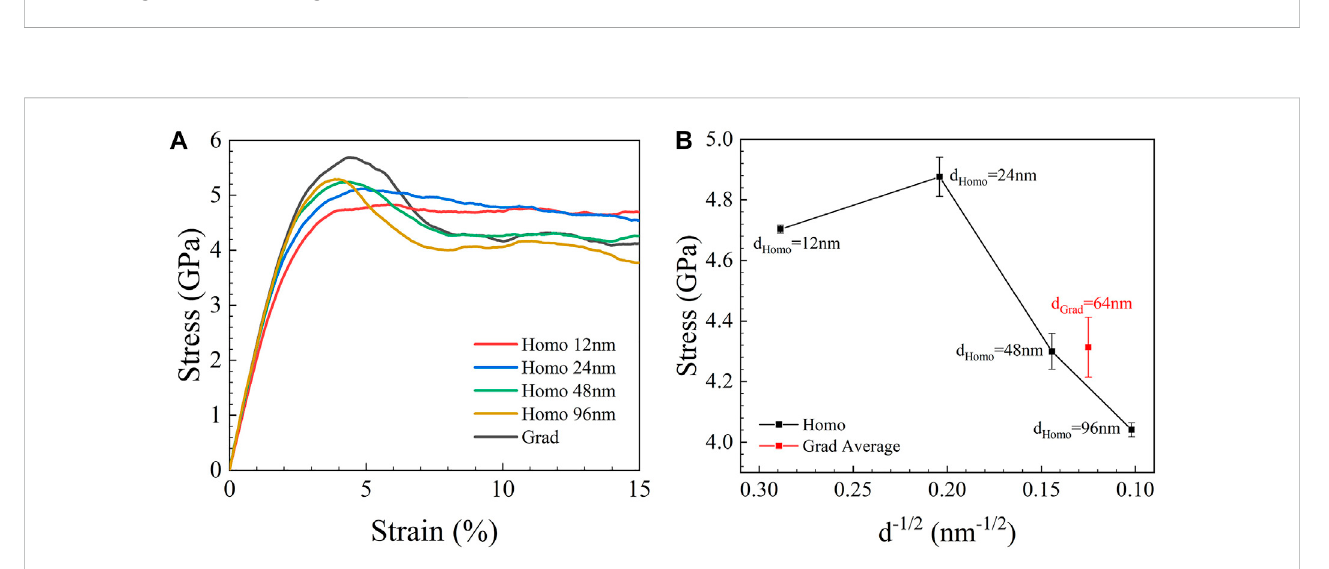
FIGURE 2 (A) Stress-Strain curves. (B) Flow stresses of the fi ve con fi